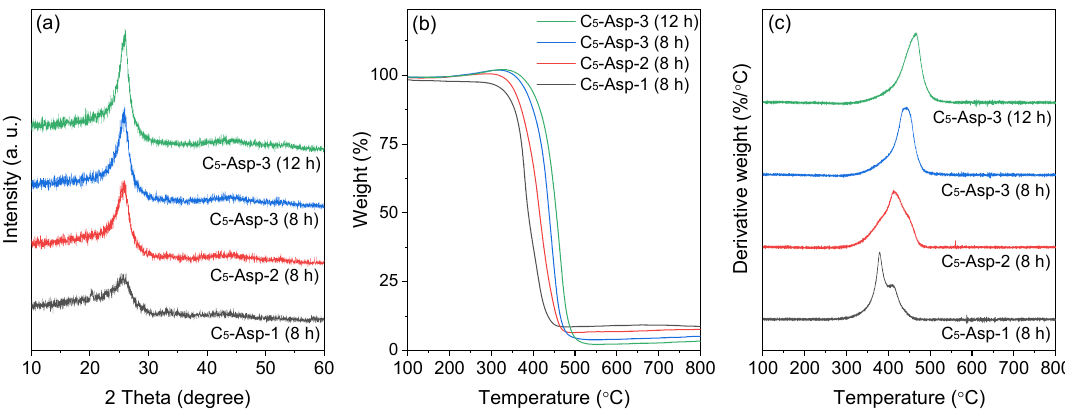
Figure 9. ( a ) XRD, ( b ) TG, and ( c ) DTG results of coke obtained from catalytic hydrocracking of asphaltene subfractions in the semi-batch system. Reaction conditions: T = 410 °C, P H2 = 110 bar, and 1000 wppm of Mo from Mo-octoate.